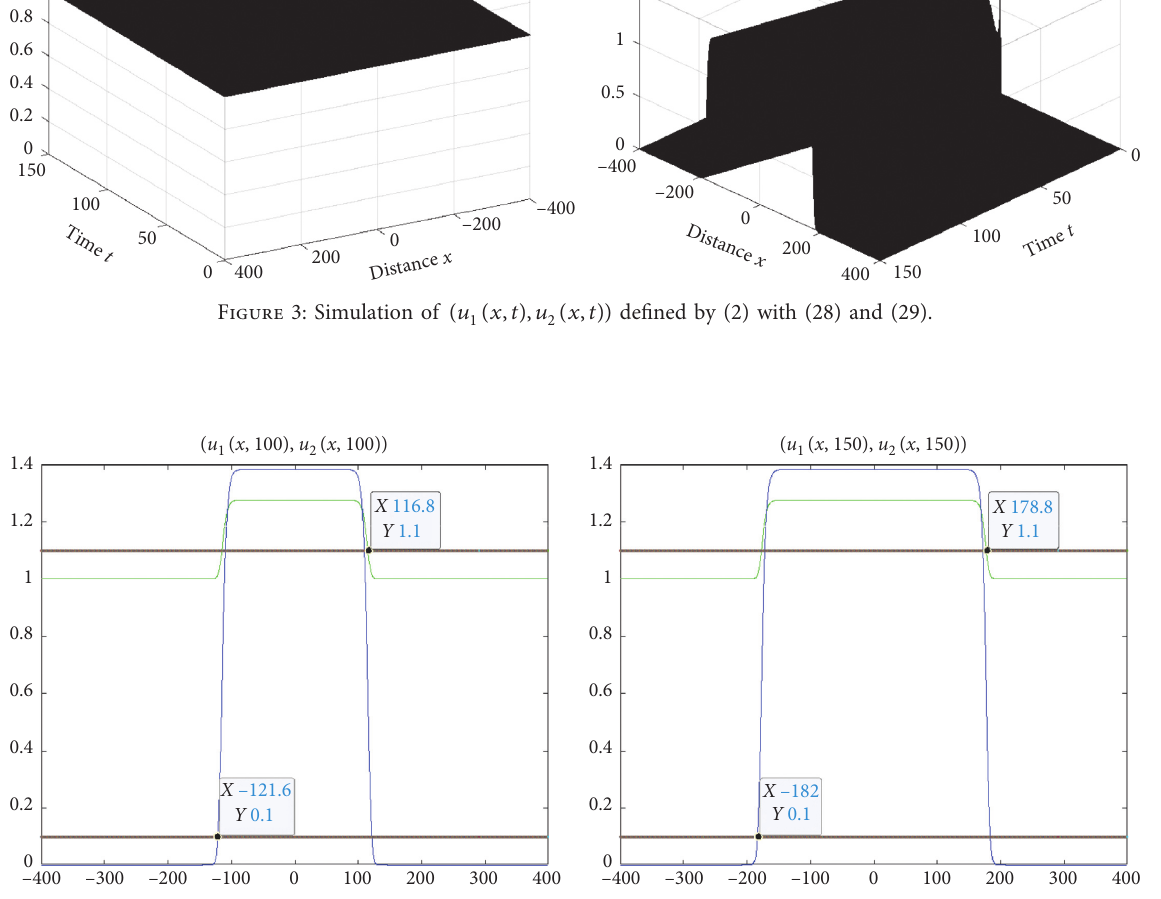
( x, t ) (green line) and u 1